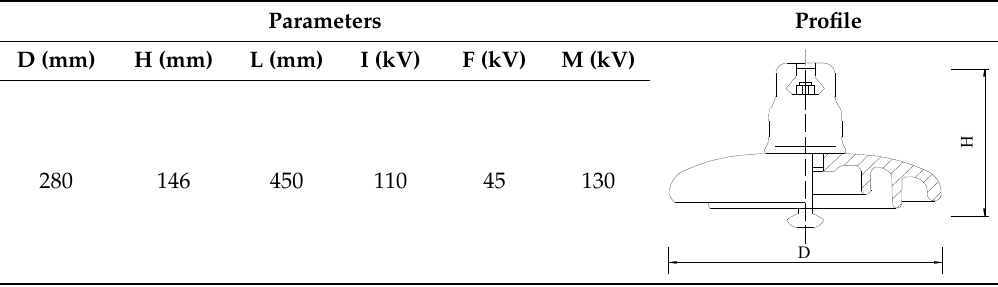
Table 2. Parameters and Profile of LXY4-160.